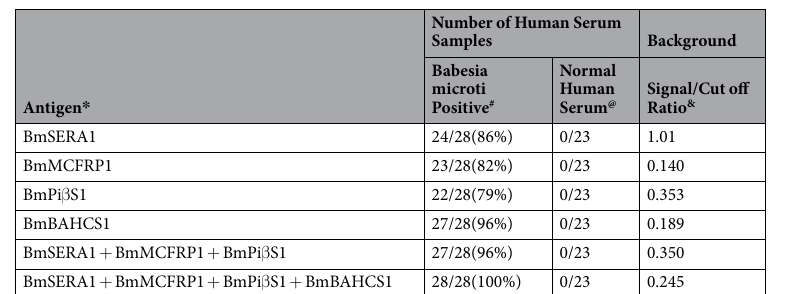
Table 2. BmELISA sensitivity and specificity. * BmSERA1 ( Babesia microti Serine Reactive Antigen 1), BmMCFRP1 ( Babesia microti Maltese Cross Form Related Protein 1) BmPi β S1. ( Babesia microti Piroplasm serum samples. # Babesia microti positive serum samples. & Signal to cut off ratio was calculated by dividing the individual absorbance (A450) by the Mean + 2 (Standard deviation) of the 23 normal human serum